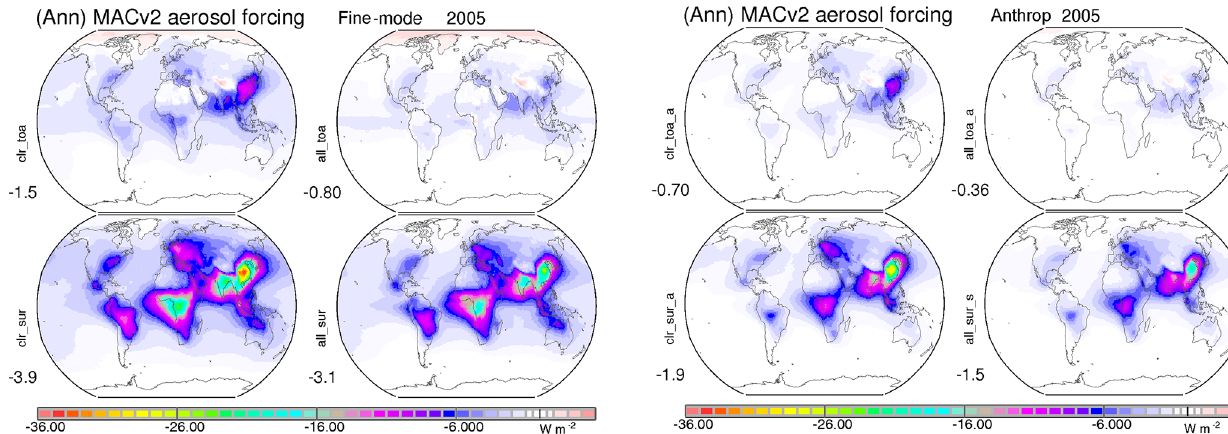
Figure 7. Annual maps for present-day fine-mode (left frame) and anthropogenic (right frame) effects in MACv2. Aerosol radiative effects at the TOA (top row) and at the surface (bottom row) are presented for clear-sky conditions (left column in each block) and all-sky conditions (right column in each block). Blue to red colors indicate a cooling and pink colors indicate weak warming. Values below the labels show global